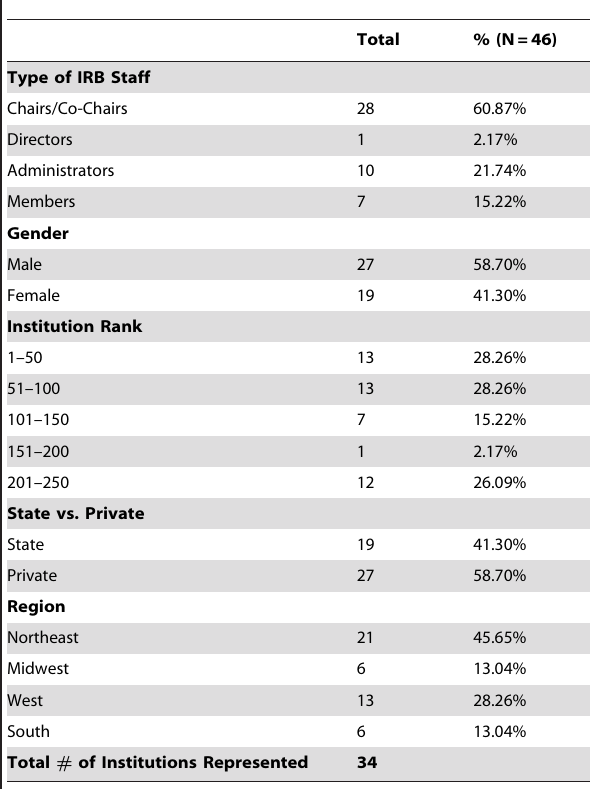
Table 1. Characteristics of the